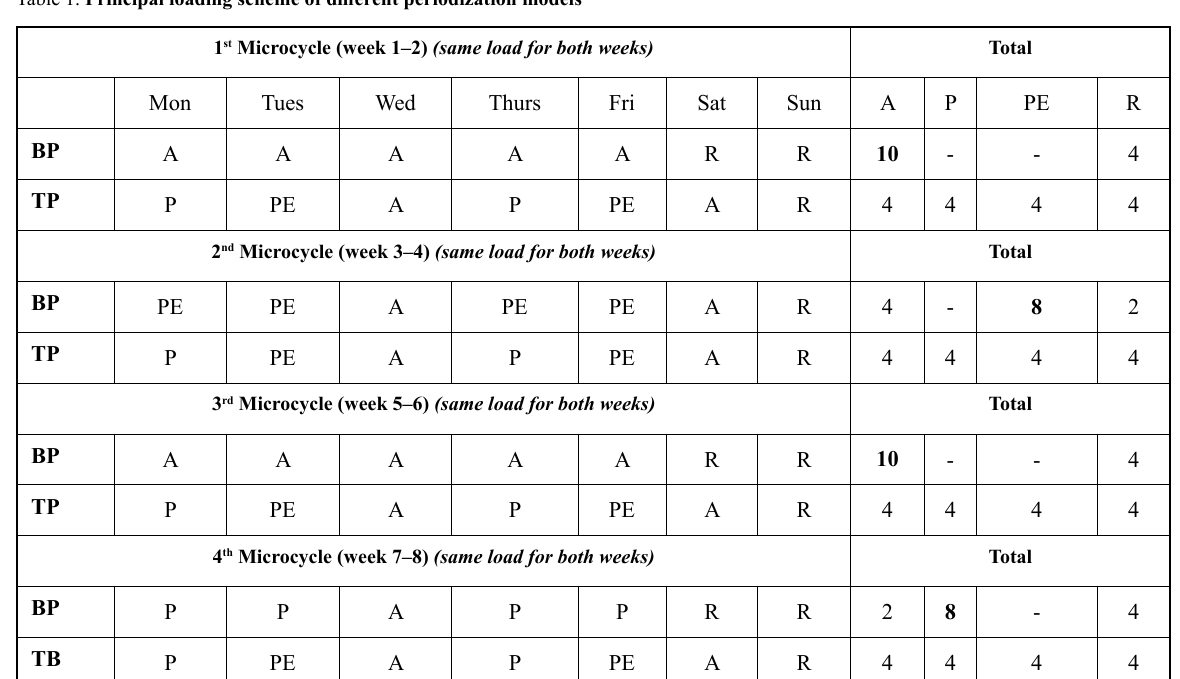
Table 1. Principal loading scheme of different periodization models